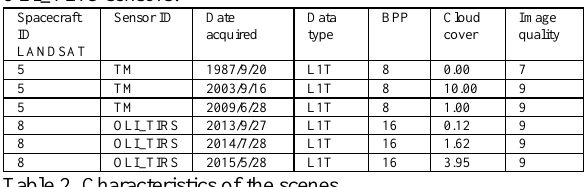
Table 2. Characteristics of the scenes